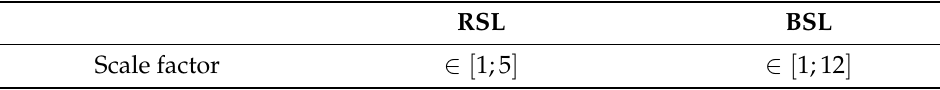
Table 1. Scale factor domains for load